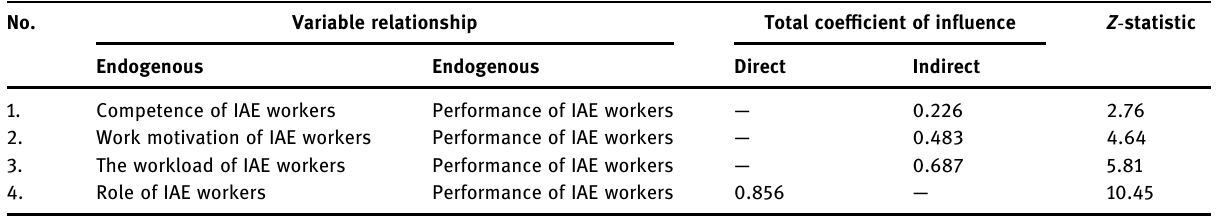
Table 6: Coe ffi cients and Z - statistic the e ff ect of exogenous variables on endogenous variables Y 2 No.